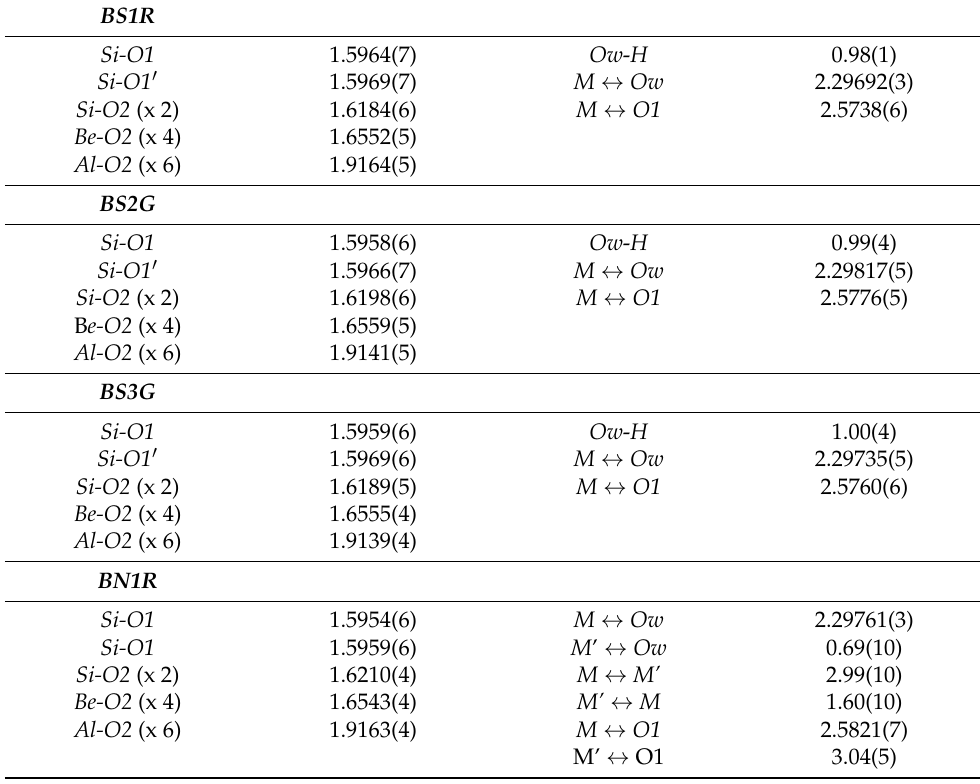
Table 5. Relevant bond distances (Å) and angles ( ◦ ) based on single-crystal XRD structure